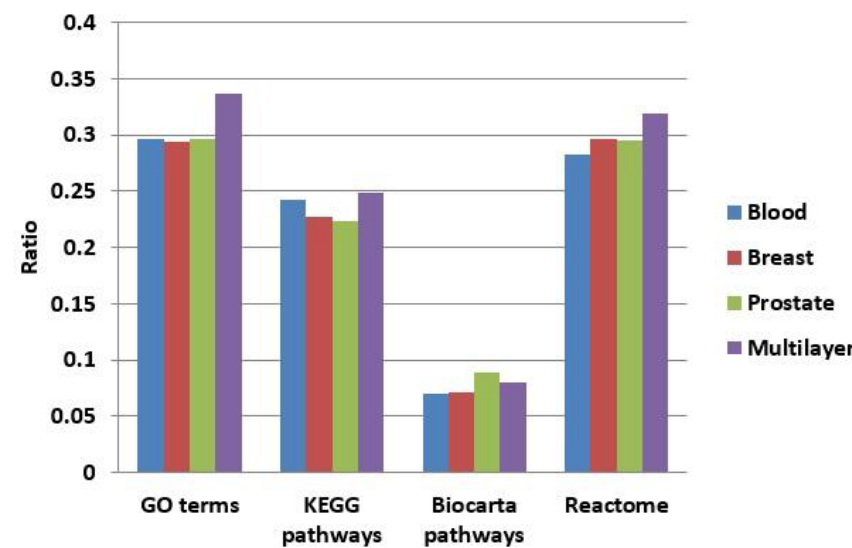
Figure 8. Comparison of the proportions of functionally enriched modules obtained for different networks using four enrichment methods.